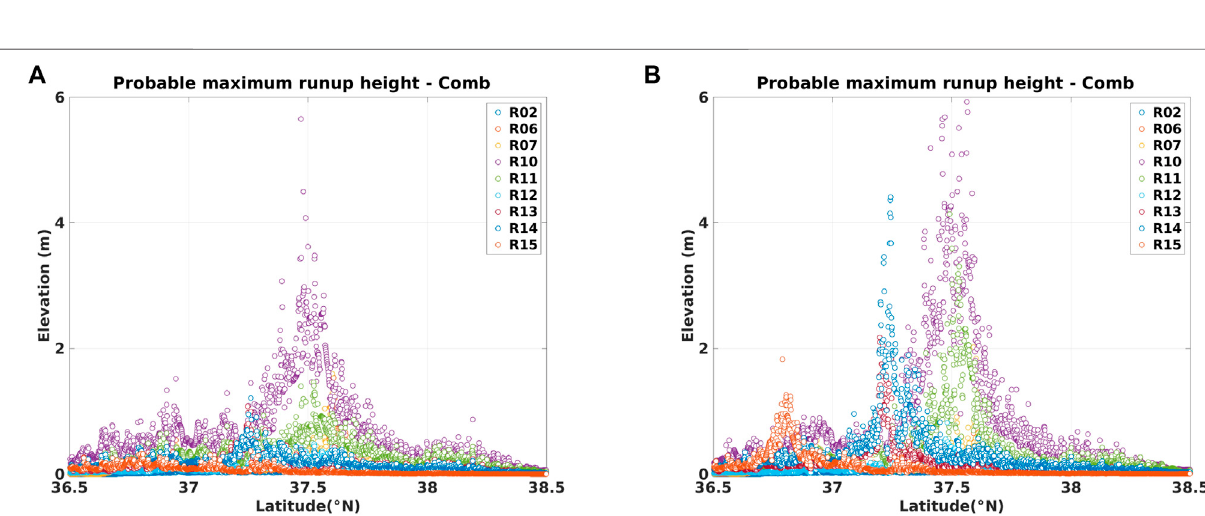
Frontiers in Earth Science |